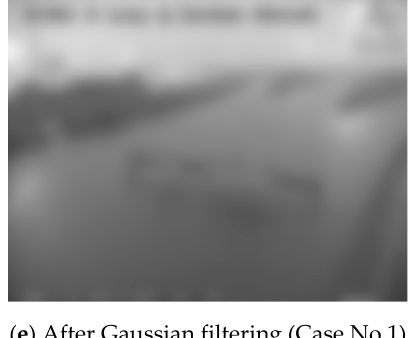
Figure 6. The results of a CCTV image (Case No.1 in Figure 6) with different de-noising methods: ( a ) original CCTV image; ( b ) an image by using Bayes shrink; ( c ) an image by using Arithmetic filtering; ( d ) an image by using median filtering and ( e ) an image by using Gaussian filtering. ( b ) Bayes shrink is the best of these de-noising methods for CCTV images. It not only removes the noise but also retains important information, including brightness, color, and resolution of the original image.